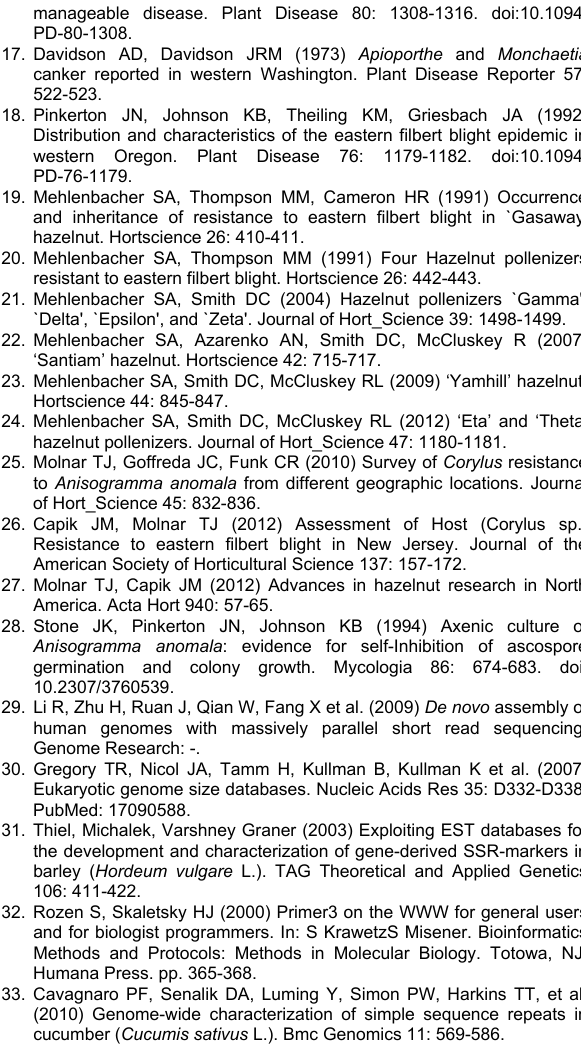
Table S1. A genome-wide database of microsatellite loci in A. anomala .